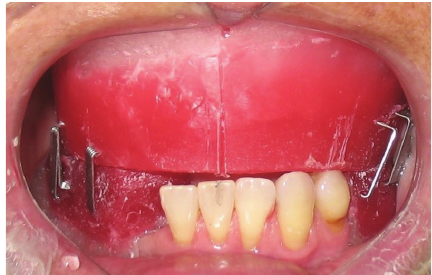
Figure 2: Evaluation of the reestablished VDO.